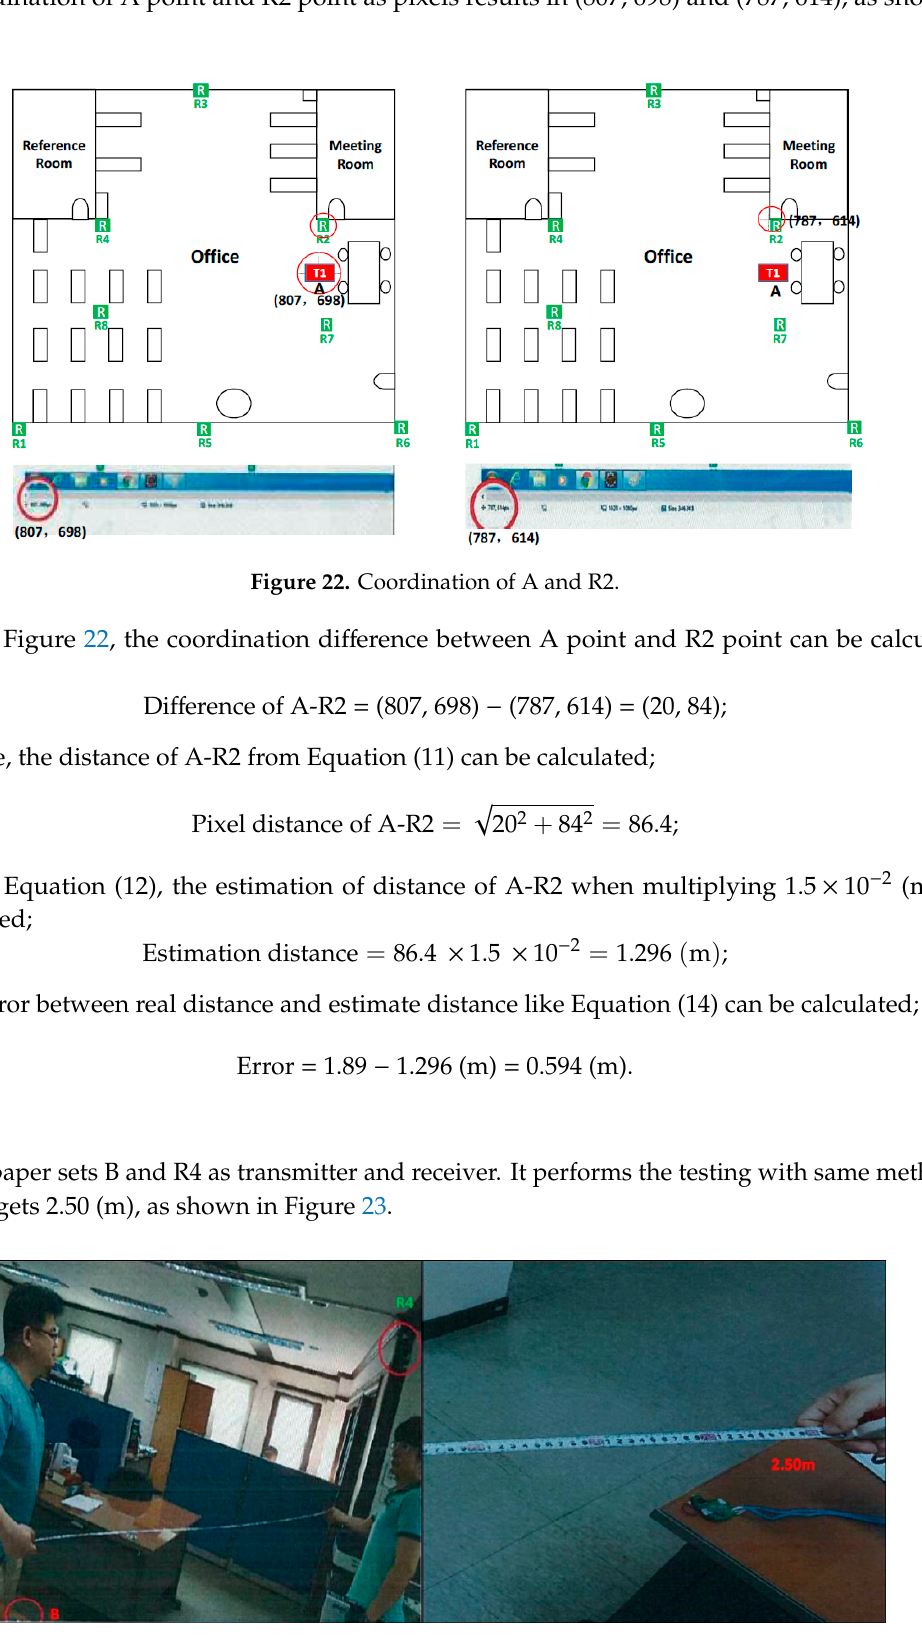
Figure 21. Location A and R2, and real distance between A and R2.